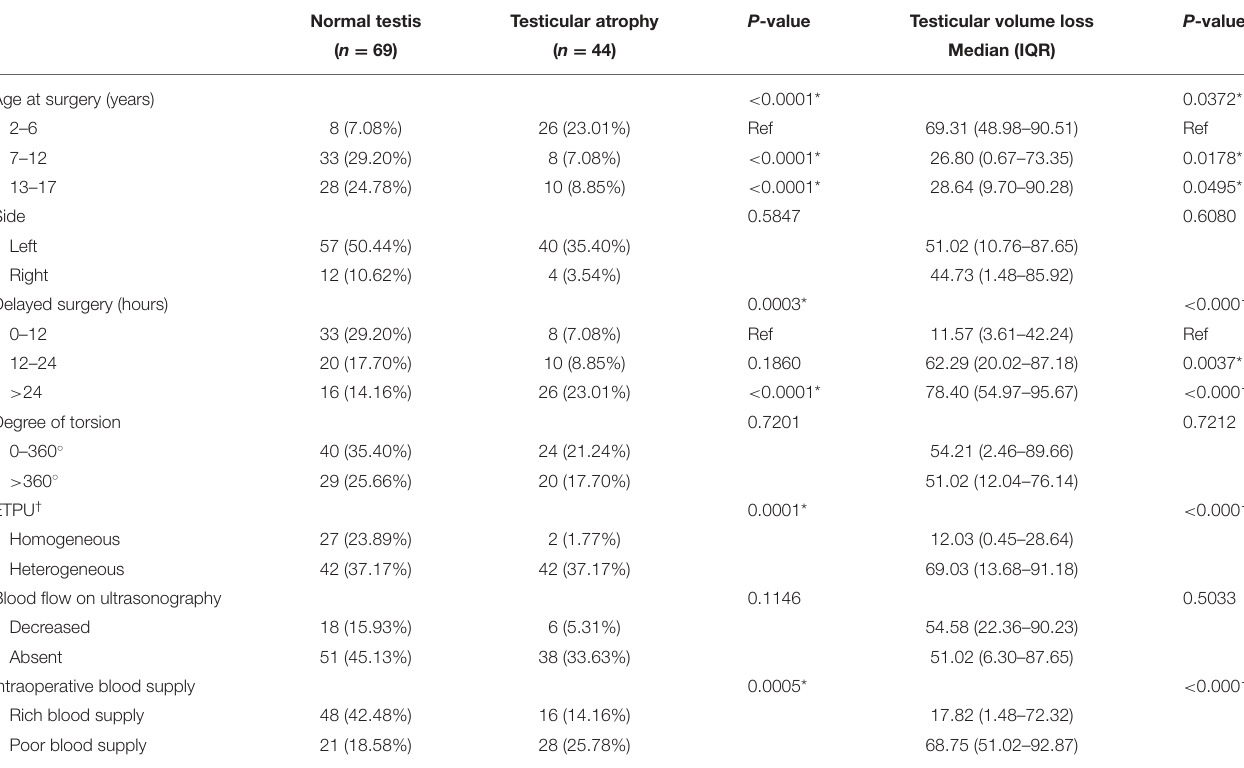
TABLE 1 | Univariate analysis of testicular atrophy and testicular volume loss. Normal testis Testicular atrophy P -value Testicular volume loss